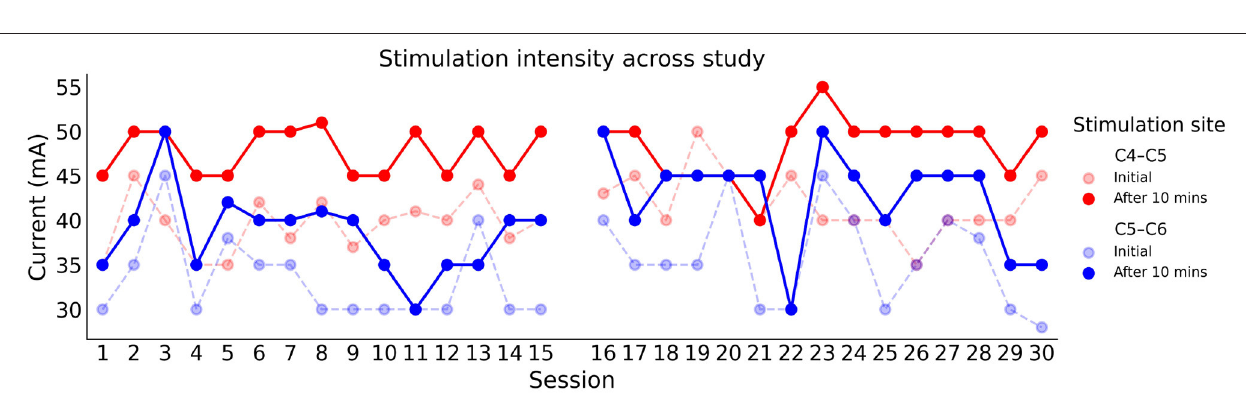
FIGURE 5 | EEG characteristics during BCI motor priming. (A,B) Average beta band power during BCI priming conditions—attempted movement and rest, respectively—across sessions. (C) Difference in beta band power between priming conditions. (D) Beta band event-related desynchronization (ERD) during movement with respect to the pre-trial interval. The shaded areas represent the 95% confidence interval from a second order linear regression.